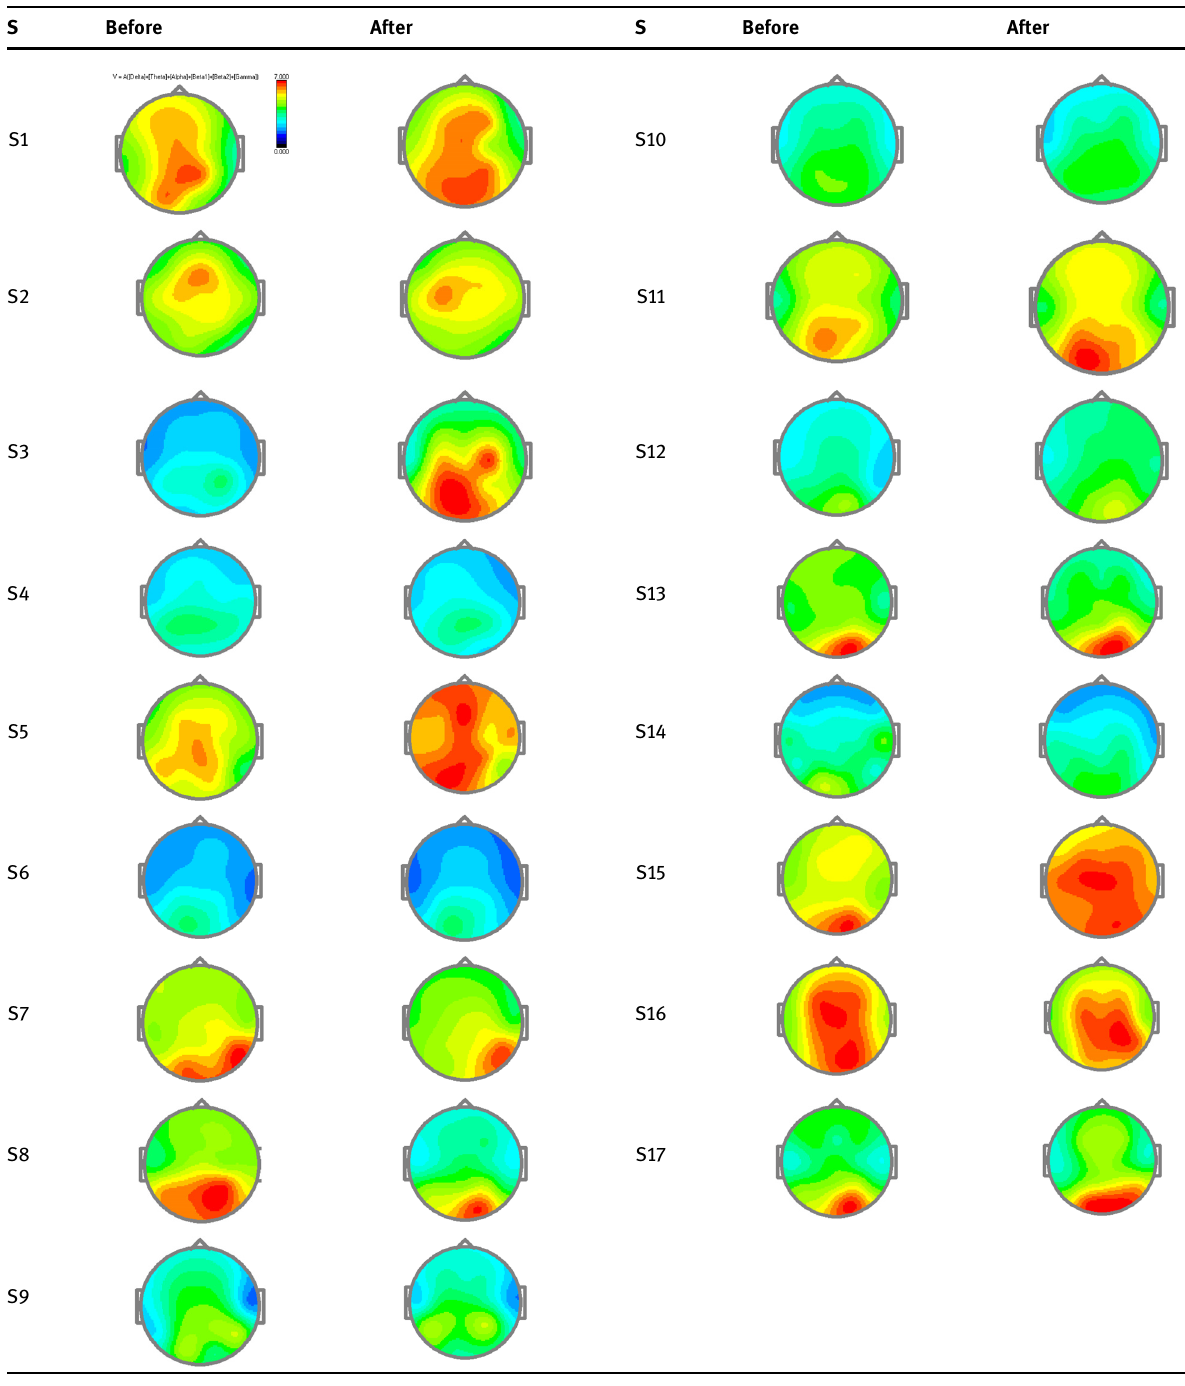
S Before After S Before